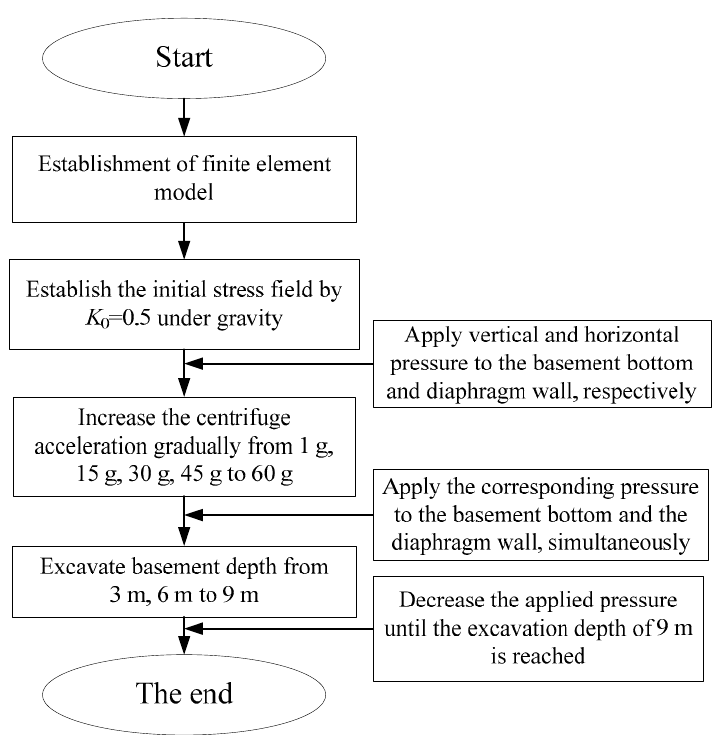
Figure 3. Flow chart of the numerical modelling procedures.